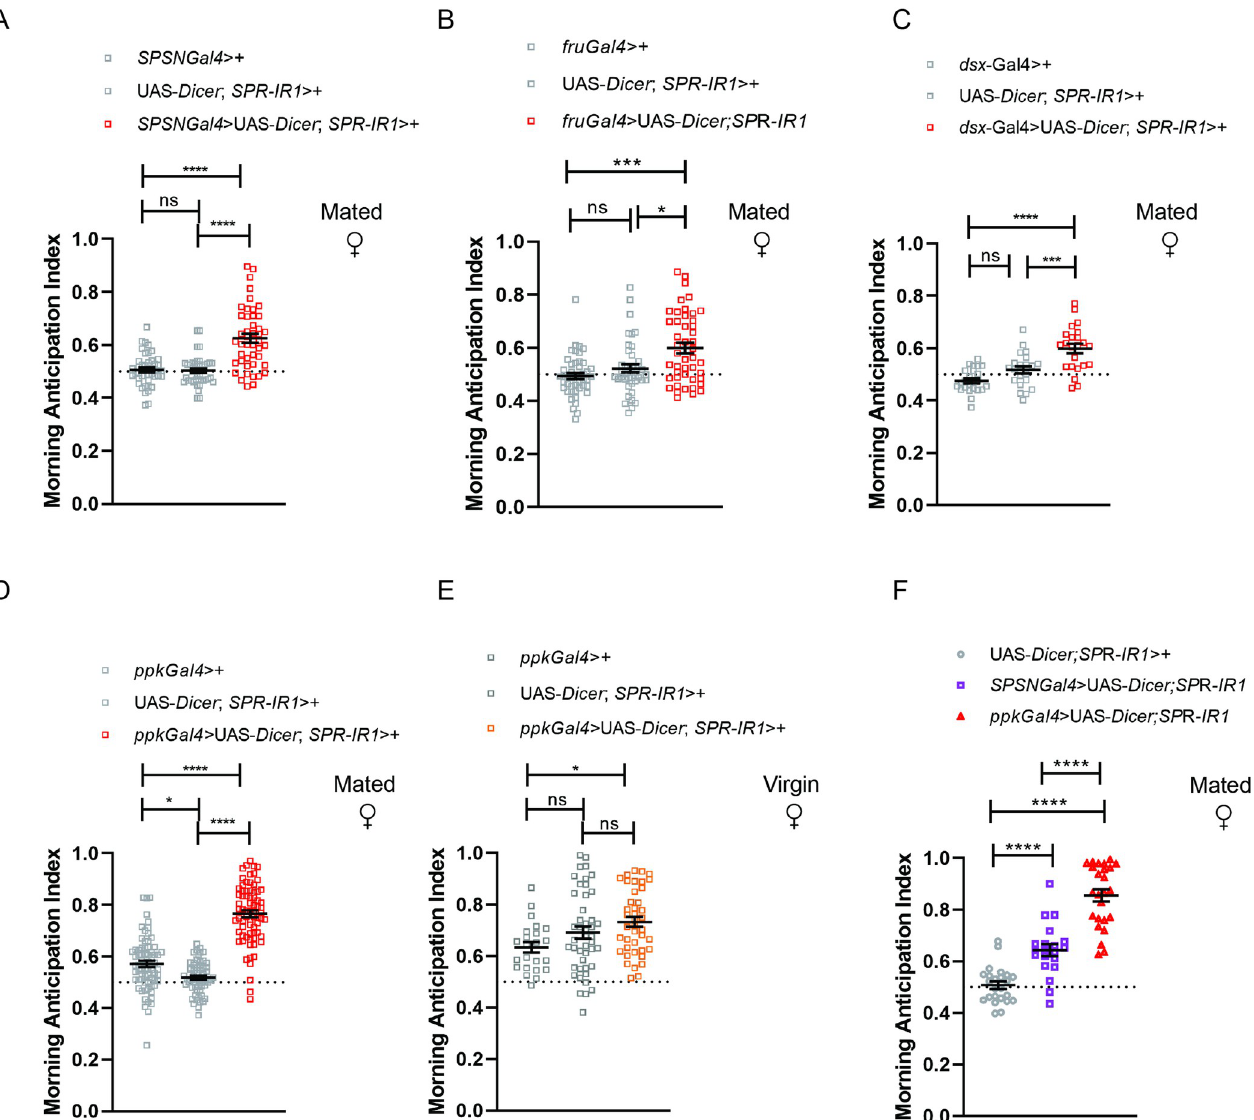
Fig 2. Downregulation of SPR in ppk + neurons restores morning anticipation. Morning anticipation index in mated females upon chronic SPR knock down in different groups of neurons and their controls. (A) SPSN- Gal4 > UAS- Dicer 2, SPR-IR 1 (n = 45); SPSN- Gal4 > + (n = 44); UAS- Dicer2 , SPR-IR1 > + (n = 44). Statistical analysis: Kruskal-Wallis test with Dunn’s multiple comparisons test: X 2 = 36.50 p < 0.0001. ( B) fru- Gal4 > UAS- Dicer 2, SPR-IR 1: (n = 46), fru- Gal4 > + (n = 46); UAS- Dicer2 , SPR-IR1 > + (n = 42). Statistical analysis: Kruskal-Wallis test with Dunn’s multiple comparisons test X 2 = 15.38 p < 0.001. (C) dsx Gal4 > UAS- Dicer2 , SPR-IR1 (n = 23); dsx Gal4 > + (n = 23); UAS- Dicer 2, SPR-IR1 > + (n = 22). One-way ANOVA with Tukey’s post hoc tests, F = 19.58 p < 0.0001. (D) Mated females: ppk- Gal4 > UAS- Dicer 2, SPR-IR 1 (n = 72); ppk- Gal4 > + (n = 71); UAS- Dicer 2, SPR-IR 1 > + (n = 62). Statistical analysis: Kruskal- Wallis test with Dunn’s multiple comparisons test X 2 = 107.5 p < 0.0001. (E) Virgin females: ppk- Gal4 > UAS- Dicer 2, SPR-IR 1 (n = 41); ppk- Gal4 > + (n = 23); UAS- Dicer 2, SPR-IR 1 > + (n = 45). One-way ANOVA with Tukey’s post hoc tests F = 4 p < 0.0210. (F) Mated females : ppk- Gal4 > UAS- Dicer 2, SPR-IR 1 (n = 25); SPSN- Gal4 > UAS- Dicer 2, SPR-IR 1 (n = 20); UAS- Dicer 2, SPR-IR 1 > + (n = 24). One-way ANOVA with Tukey´s post hoc test F = 75.04 p < 0.00018. Dots represent independent flies, the mean and SEM are shown. Statistically significant differences are represented by � p < 0.05, �� p < 0.01, ��� p < 0.001, ���� p < 0.0001, ns = not